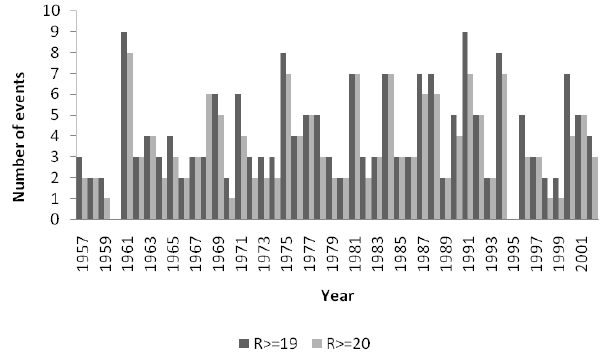
Fig. 1. The annual distribution of heavy rainfall events.